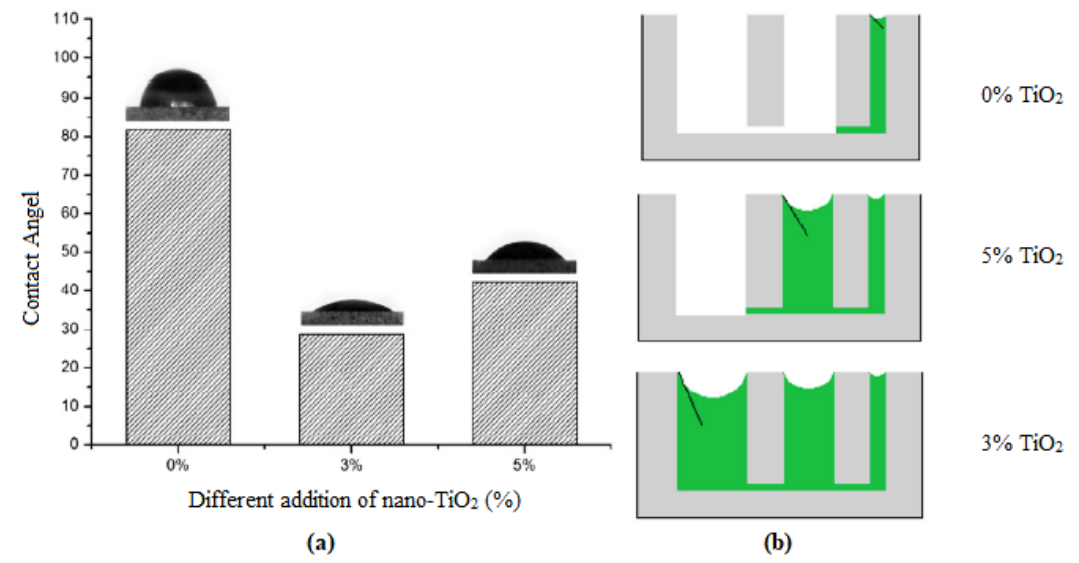
Figure 15. ( a ) Effect of nano-TiO 2 addition on the cement particle contact angle. ( b ) Capillary pores filled with water before and after addition of nano-TiO 2 [123].